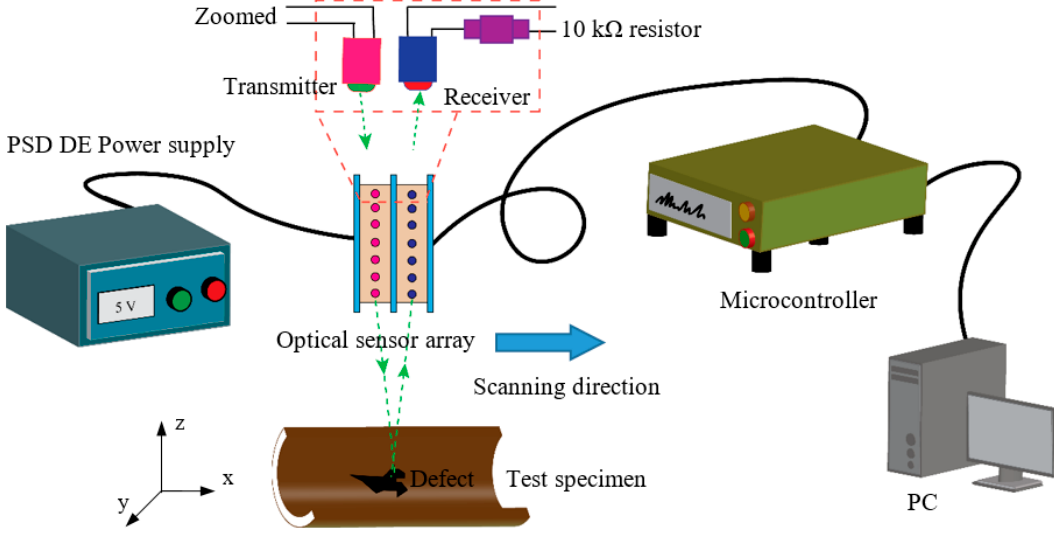
Figure 4. Schematic diagram of the self-designed experimental setup with interconnections.